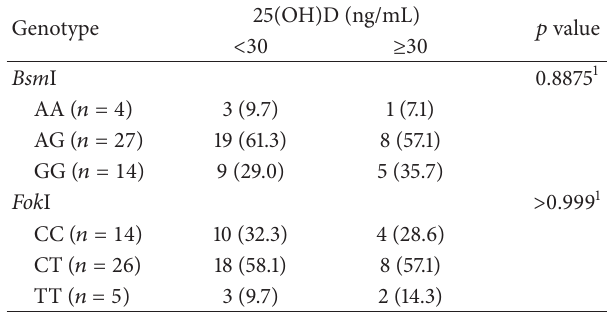
Table 4: VDR polymorphisms and vitamin D levels in NF1